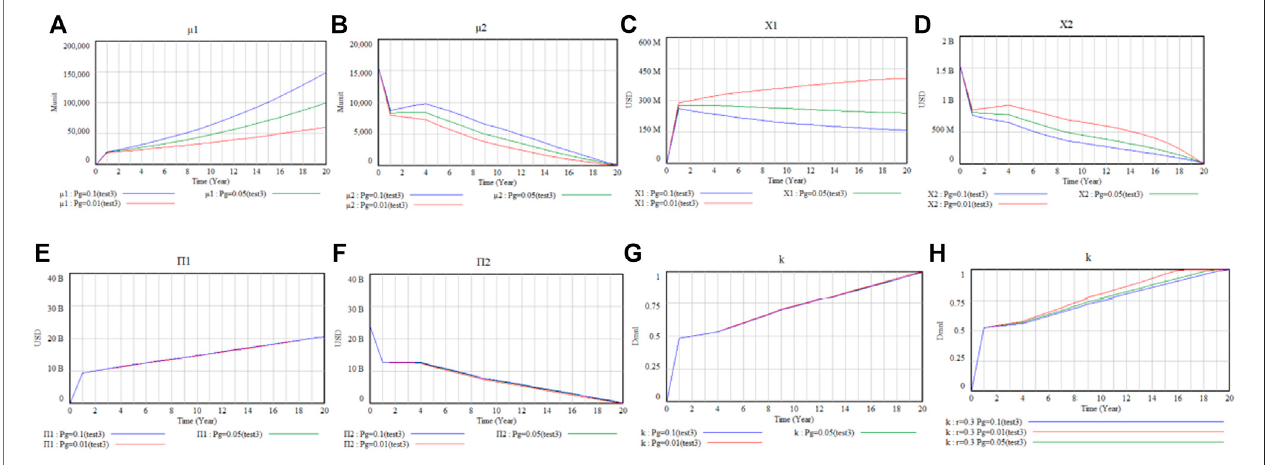
FIGURE 11 | Changes in the factors as platform maturity varies: (A) The change of μ 1; (B) The change of μ 2; (C) The change of X1; (D) The change of X2; (E) The change of Π 1; (F) The change of Π 2; (G) The change of k; (H) The change of k.